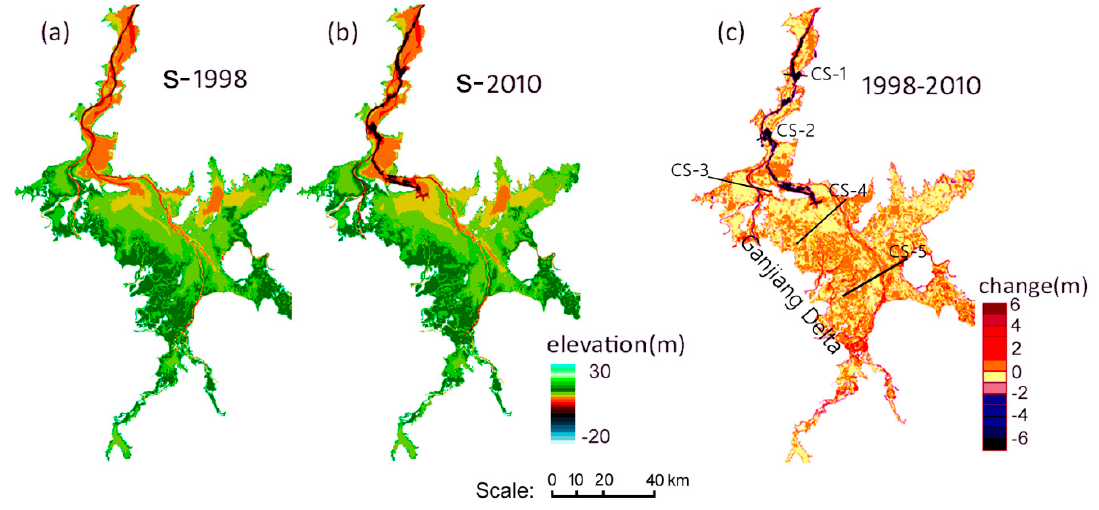
Figure 3. Two scenarios of bottom topography digital elevation models (DEMs) of Poyang Lake in ( a ) 1998 and ( b ) 2010; and ( c ) relative changes between 1998 and 2010.